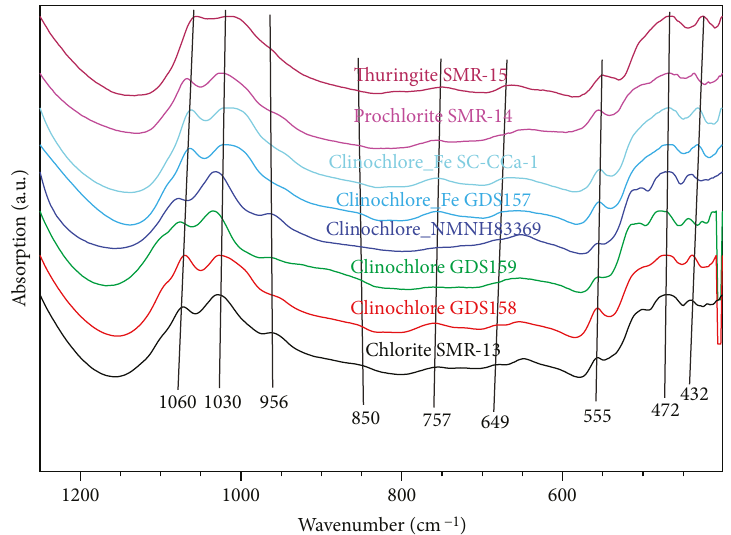
Figure 4: Infrared spectra of bending vibrations of hydroxyl groups in the 400 – 1250 cm − 1 spectral range obtained on the chlorite series in the USGS spectral library. The band positions are the average values from the IR spectra shown in this